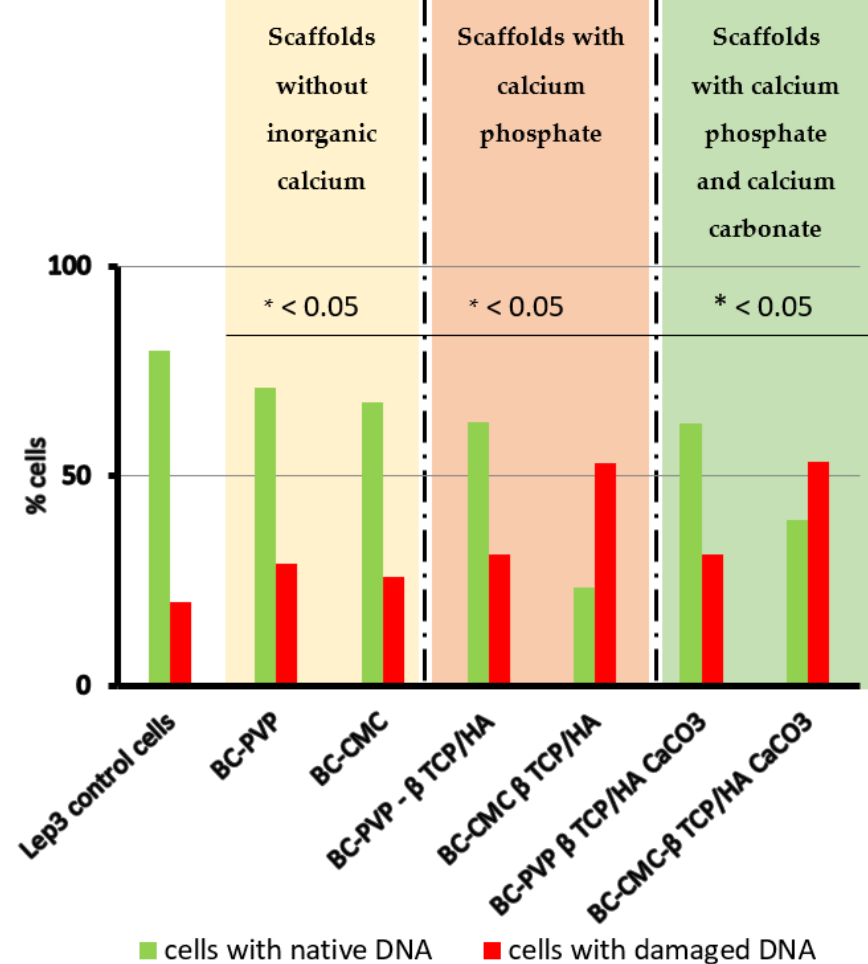
Figure 2. Genotoxicity testing of the studied biocompatible scaffolds was done by the method of Comet Assay in Lep-3 cells in the presence of extracts of all six BC based hydrogel scaffolds. Data quantitation proceeded with estimation of the percentage of comets by assuming the total number of objects per probe ( n = 1000) as 100% and the percentage of comets, i.e., cells with damaged DNA was estimated and represented as a graph. Student t test was performed and the estimated p values for all probes in comparison to the control were statistically significant p < 0.05.